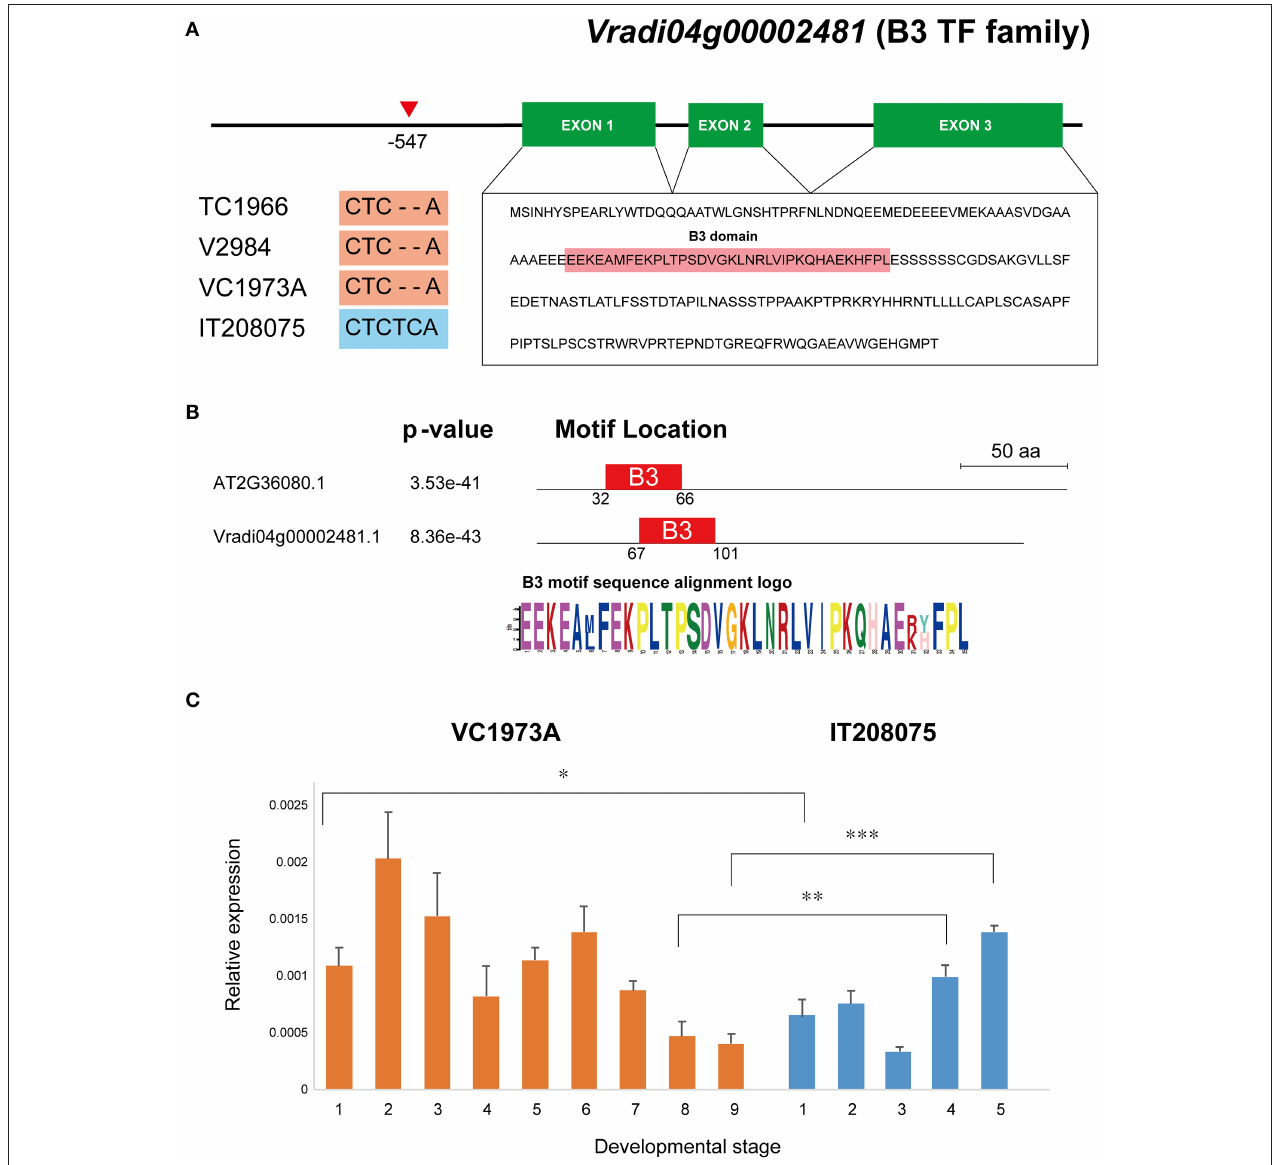
FIGURE 5 | Gene structure and expression level of Vradi04g00002481 , which encodes a B3 TF family protein. (A) Two-base insertion specific to IT208075 located − 547 bp upstream of the coding region of the gene. Three mungbean lines producing compound racemes, VC1973A, V2984, and TC1966, showed a two-base deletion at this point, indicated by a red triangle. Vradi04g00002481 consists of 3 exons encoding 224 amino acids and contains a B3 domain. (B) B3 motif sequence alignment between AT2G36080 and Vradi04g00002481. (C) Expression levels of Vradi04g00002481 in shoot apical tissue from lines VC1973A and IT208075 at each developmental stage. * P < 0.05; ** P < 0.01; *** P <